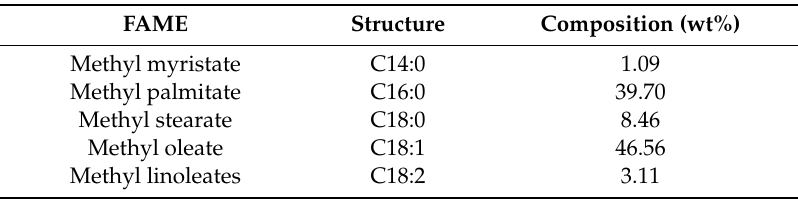
Table 5. Fatty acid profile of